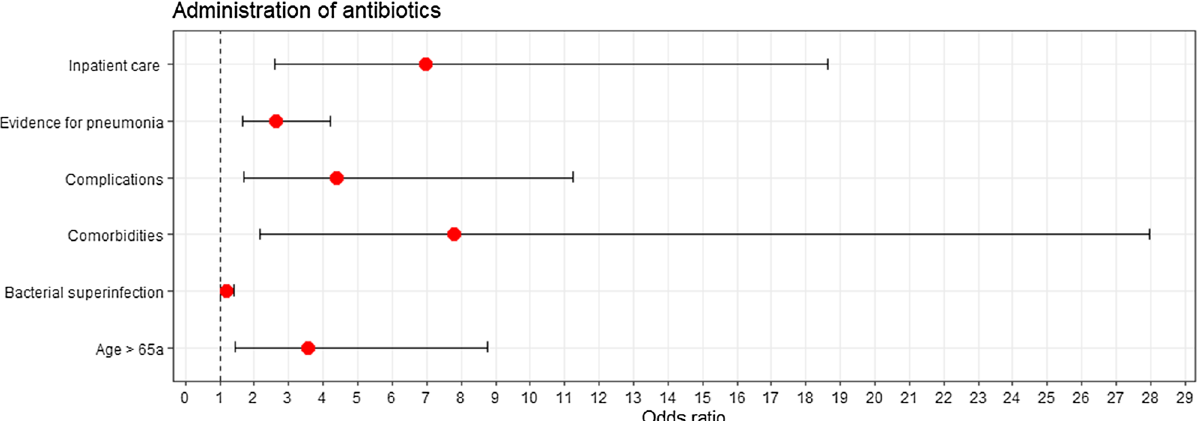
Figure 3. Demonstrates factors influencing administration of antibiotics in patients with RSV infections 20 . Listed factors were inpatient care (yes/no), evidence for pneumonia (defined as radiological evidence for pneumonia), complications (respiratory complications and bacterial or fungal superinfections), comorbidities (cardiac disease, pulmonary disease, type 2 diabetes mellitus, oncological disease, terminal dialysis-dependent kidney insufficiency and solid-organ transplant recipients), bacterial superinfections (bacterial growth in blood cultures) and age > 65a (yes/no).